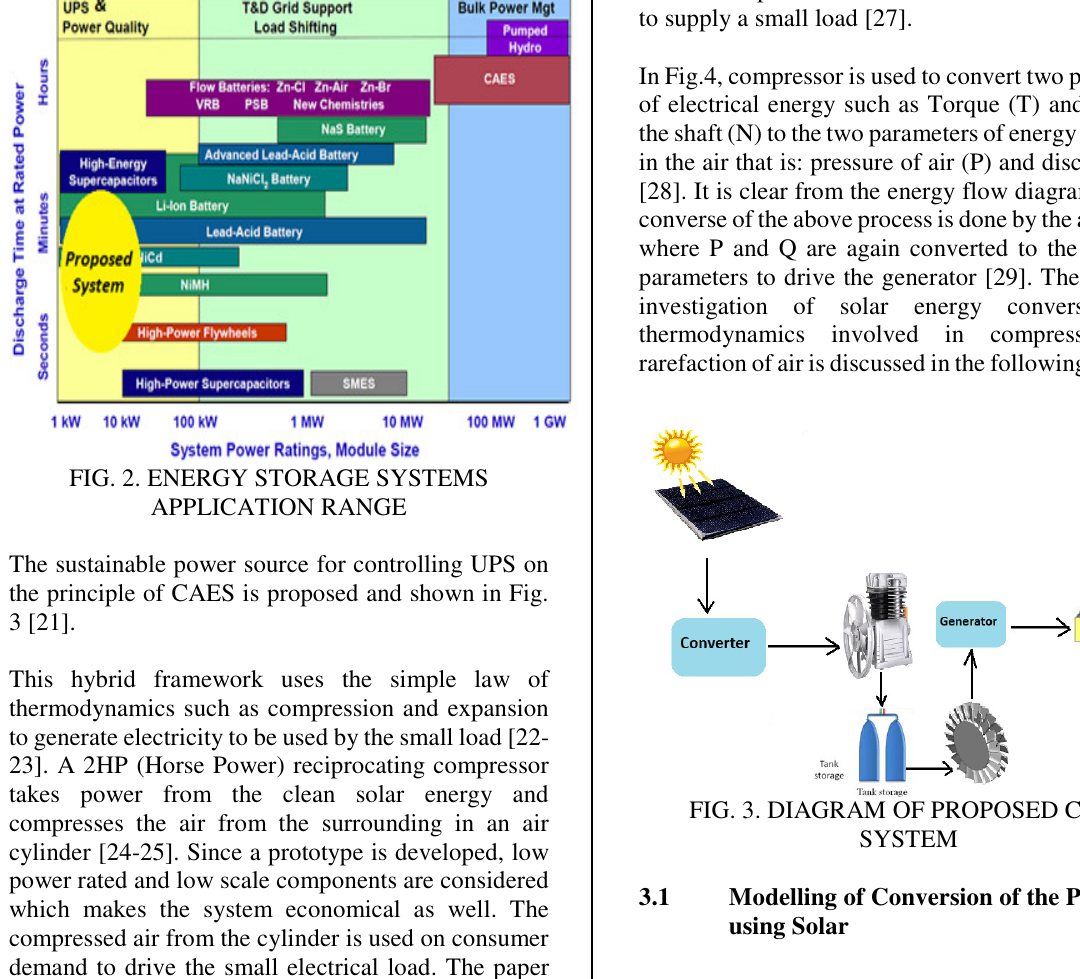
FIG. 3. DIAGRAM OF PROPOSED